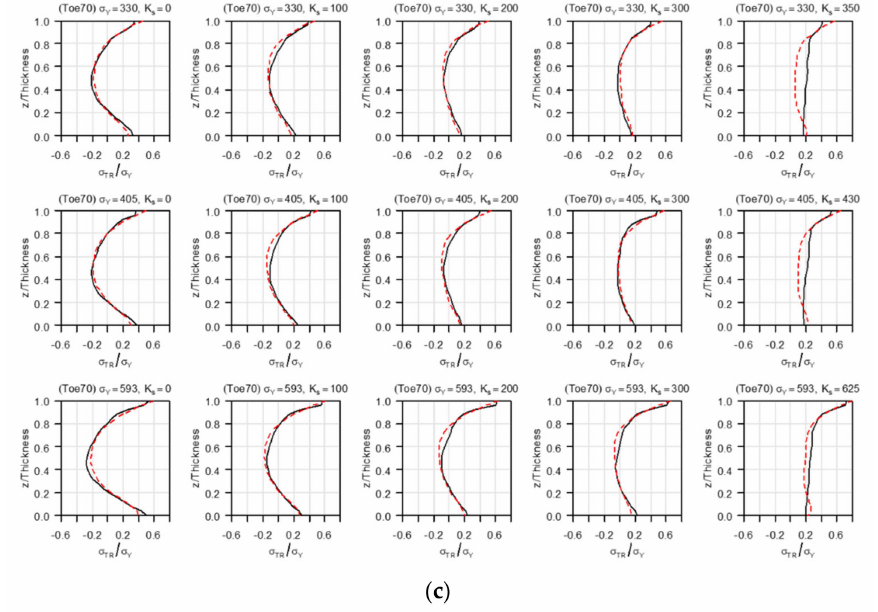
Figure 20. Comparison of analysis and prediction results at the welding toe (black solid line: analysis results; red dotted line: prediction results). ( a ) B = 25 mm; ( b ) B = 50 mm; and ( c ) B = 70